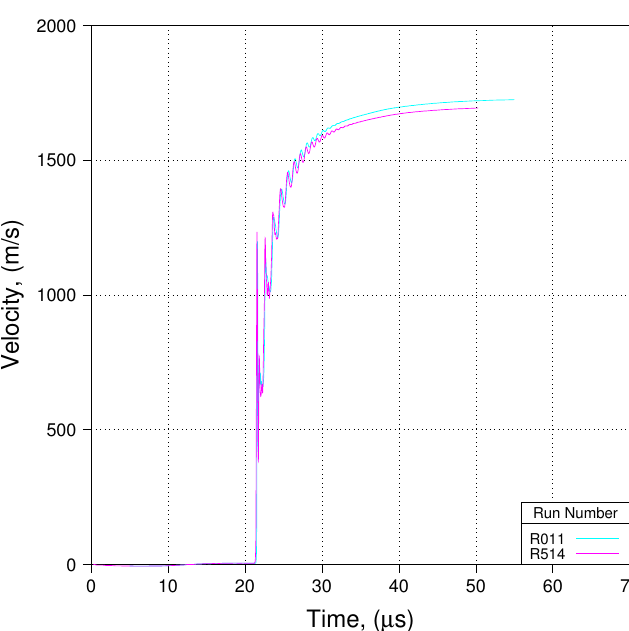
Figure 11. With and without lower aluminum plate (all times in µ s).